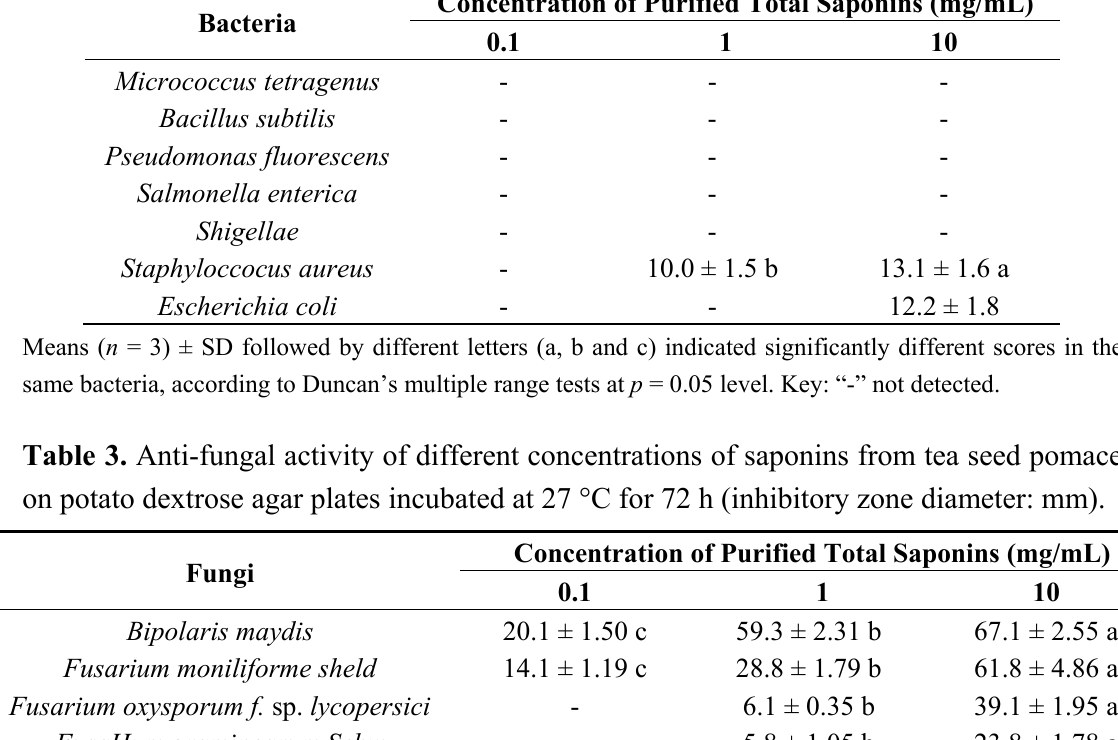
Means ( n = 3) ± SD followed by different letters (a, b and c) indicate significantly different scores in